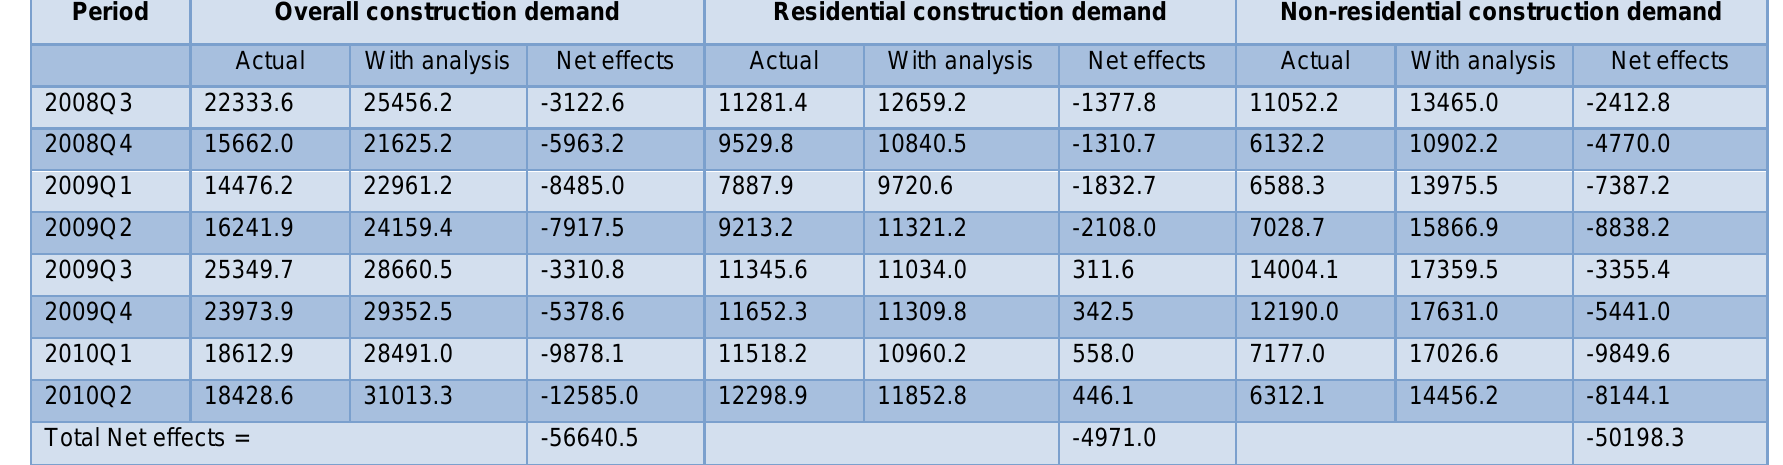
Table 3 Results of the impact of the late 2000s global financial crisis on the construction demand (Scenario A) Note: the duration of the intervention period is from 2008Q3 to 2010Q2